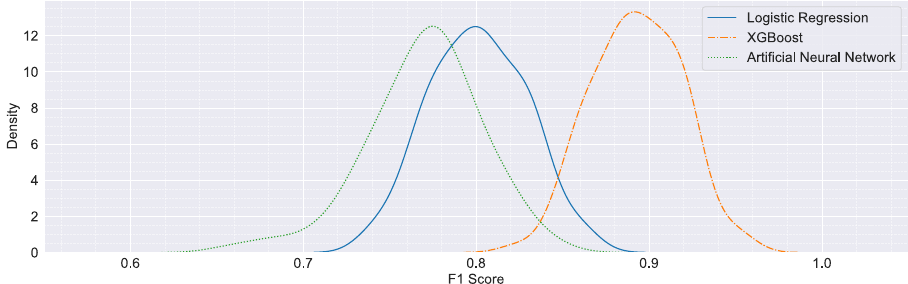
Figure 12. F1 Score of Machine Learning Models.